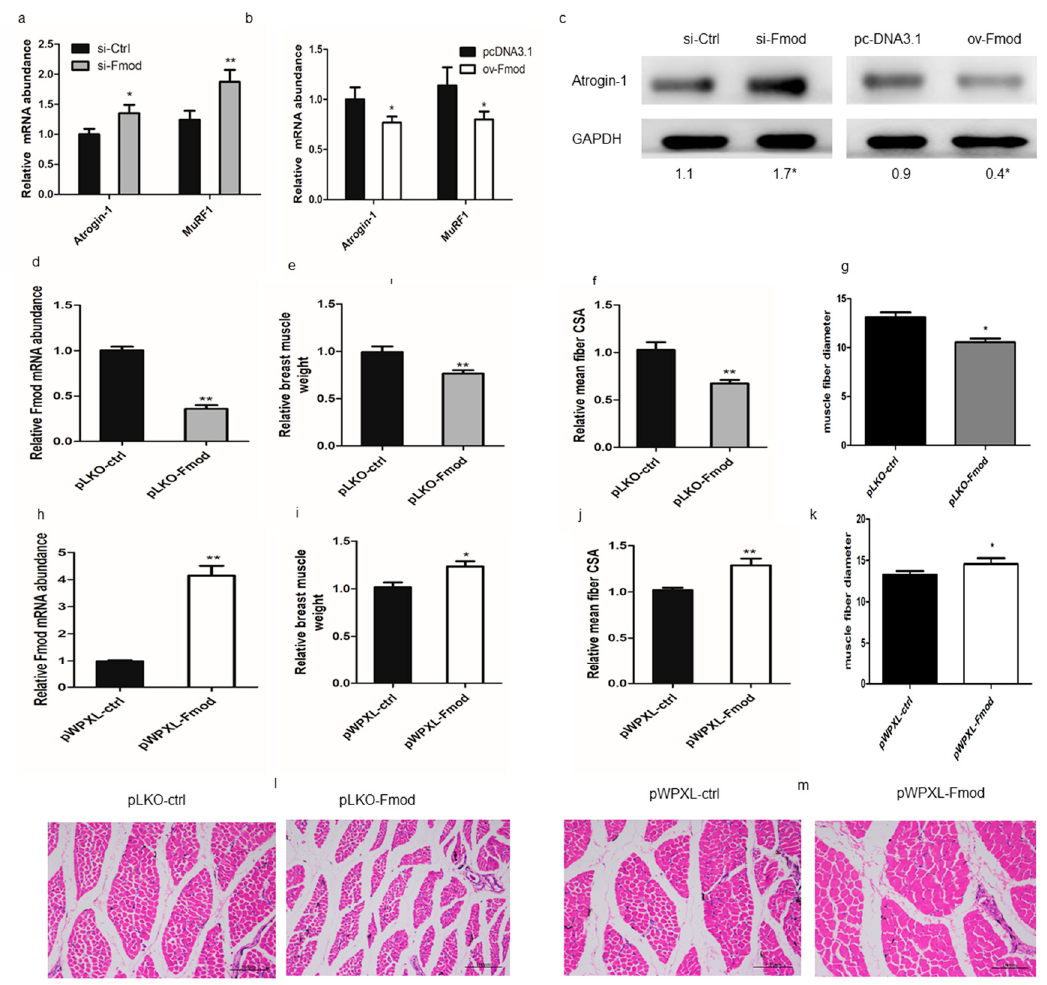
Figure 4. Effects of Fmod on skeletal muscle atrophy in chickens. ( a , b ) The expression levels of Atrogin-1 and MuRF1 after knockdown or overexpression of Fmod. ( c ) Western blot analysis of Atrogin-1 protein levels after transfection. ( d , h ) The Fmod mRNA expression in chick breast muscles of pLKO-Fmod and pWPXL-Fmod groups. ( e , i ) The relative muscle weights, ( f , j ) means of the muscle fiber cross-section area, and ( g , k ) fiber diameters of breast muscles in pLKO-Fmod and pWPXL-Fmod groups. ( l , m ) Hematoxylin and eosin (H&E) staining of breast muscle fiber cross-sections in pLKO-Fmod and pWPXL-Fmod groups. Note: * p < 0.05, ** p < 0.01.